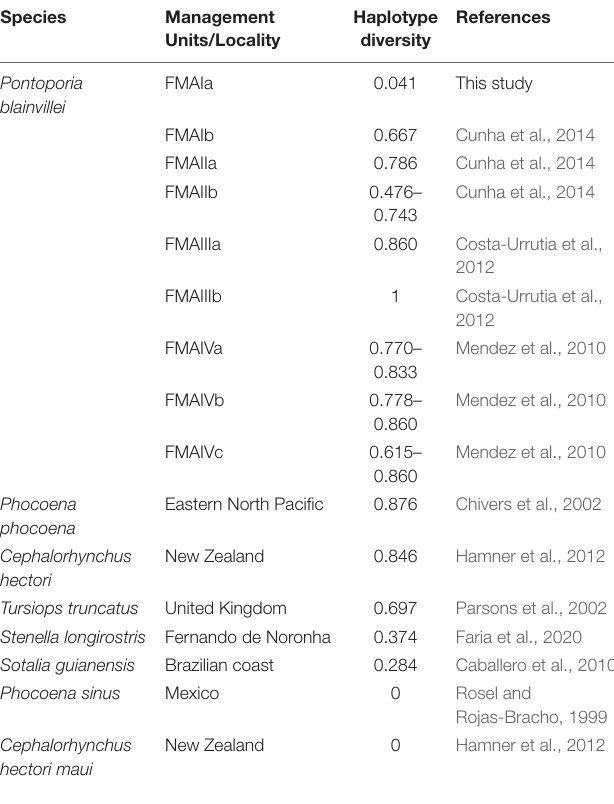
TABLE 6 | Comparison of Pontoporia blainvillei haplotypic diversity between management units along species distribution and comparison with other small cetacean